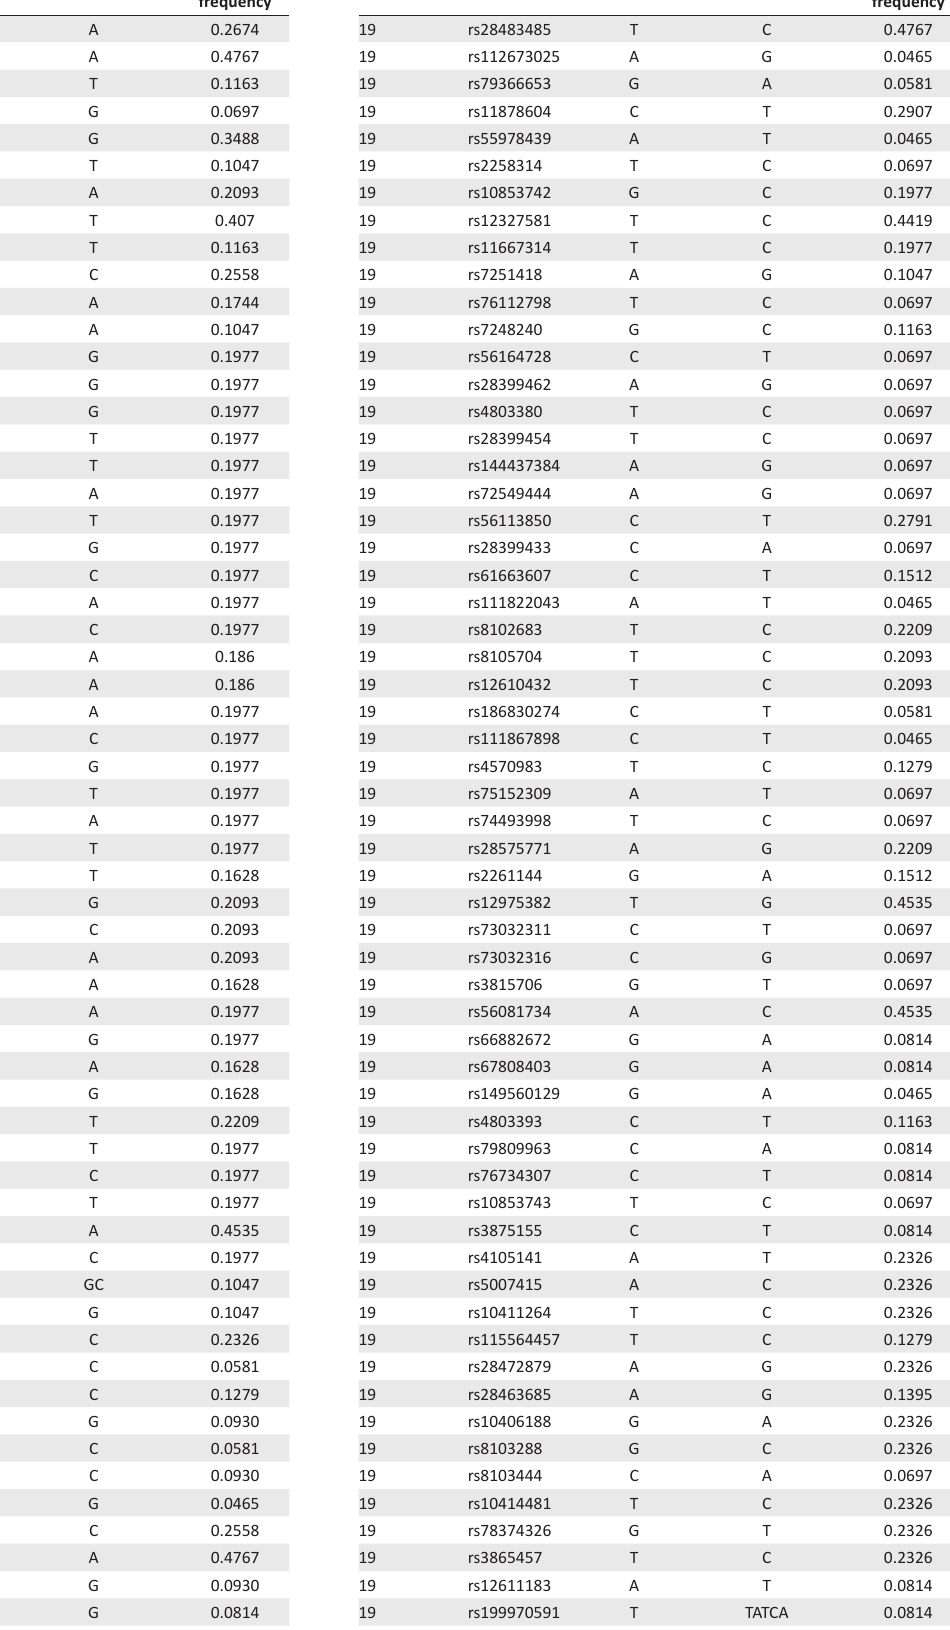
Table 1-A1 (Continues...): Minor allele frequencies for 1846 polymorphisms in 43 black South Africans. Chromosome Polymorphism Minor allele